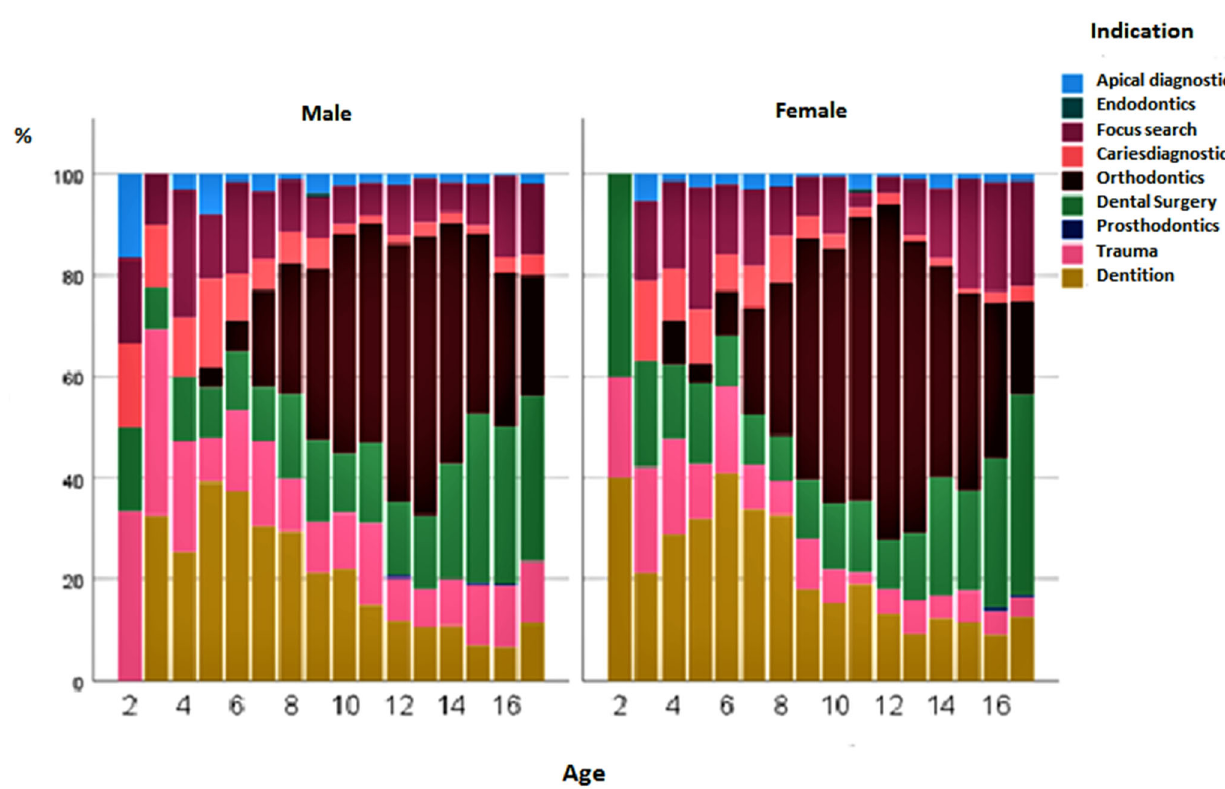
Figure 4. Gender distribution of dental indications for radiographs from 1 to 18 years of age.